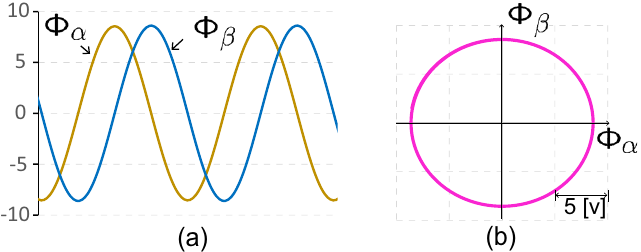
Figure 2. The regressor vector Φ with the injection signal at zero speed: ( a ) Time plots of Φ α and Φ β , and ( b ) its Lissajous